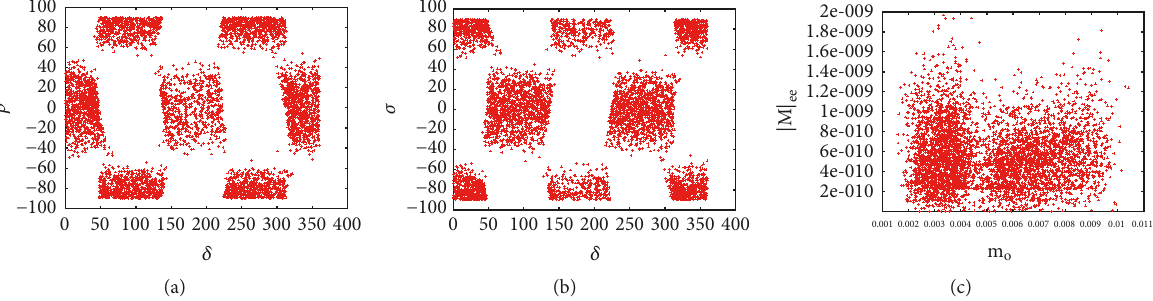
Figure 2: Correlation plots for texture 𝐴 1 (NS) for type Y at 3 𝜎 CL. The symbols have their usual meaning. 𝛿,𝜌 , and 𝜎 are measured in degrees, while |𝑀| 𝑒𝑒 and 𝑚 0 are in eV units.